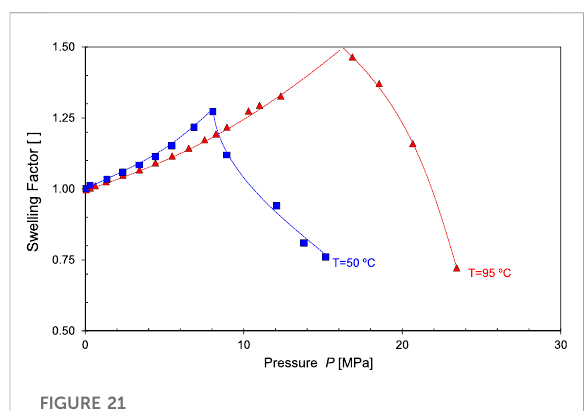
FIGURE 21 Miscibility and oil volume change. There are two competing processes: CO 2 dissolution in oil prevails at low pressure and causesoilswelling;ontheotherhand,lighthydrocarbonsvaporize into CO 2 and oil shrinks at high pressure. Data source: Rezk and Foroozesh (2019).